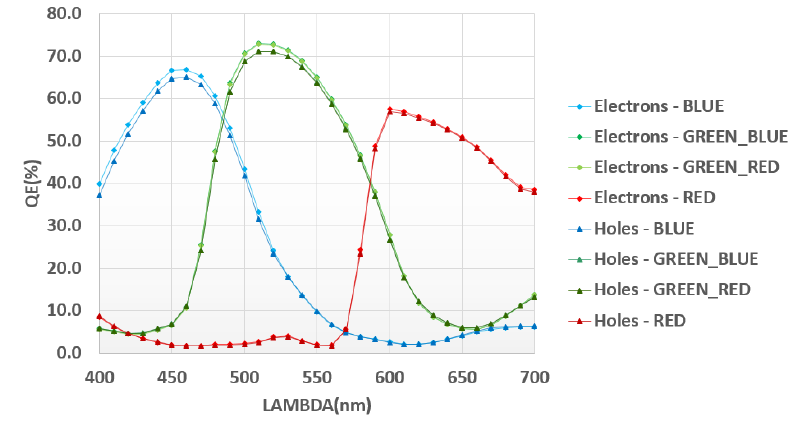
Figure 11. QE electrons and holes.